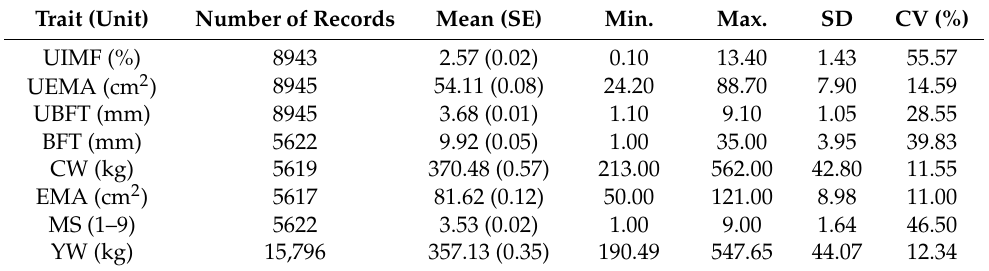
UIMF: Ultrasound intramuscular fat content; UEMA: Ultrasound longissimus muscle area; UBFT: Ultrasound backfat thickness; BFT: Backfat thickness; CW: Carcass weight; EMA: Eye muscle area; MS: Marbling score; YW: Yearling weight; SE: Standard error; SD: Standard deviation; CV: Coefficient of